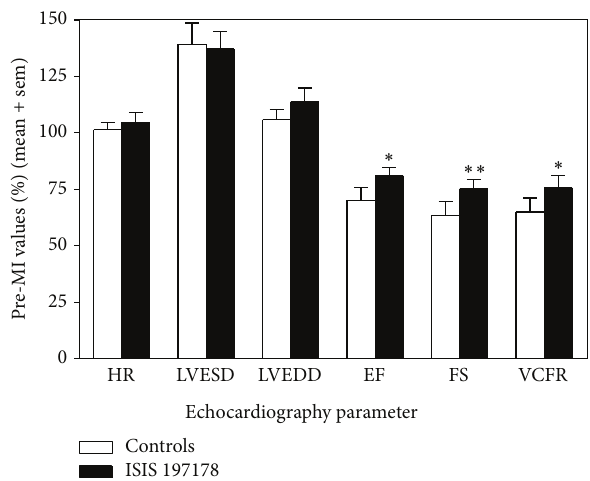
Figure 2: ASO-mediated lowering of CRP in rats subjected to coro- nary artery ligation improves myocardial infarction (MI) induced cardiac dysfunction. LV function was measured by echocardio- graphic analysis in rats at baseline and at 1wk after MI. Heart rate (HR), LV end-systolic dimension (LVESD), LV end-diastolic dimension (LVEDD), ejection fraction (EF), fractional shortening (FS), and the mean velocity of circumferential shortening (VCFR) were calculated as described in the Materials and Methods . The results shown are for 𝑛 = 12 rats treated with ISIS 197178 versus 𝑛 = 9 controls (see the Results section for details). Single and double asterisks indicate 𝑃 < 0.05 and 𝑃 < 0.005 for unpaired 𝑡